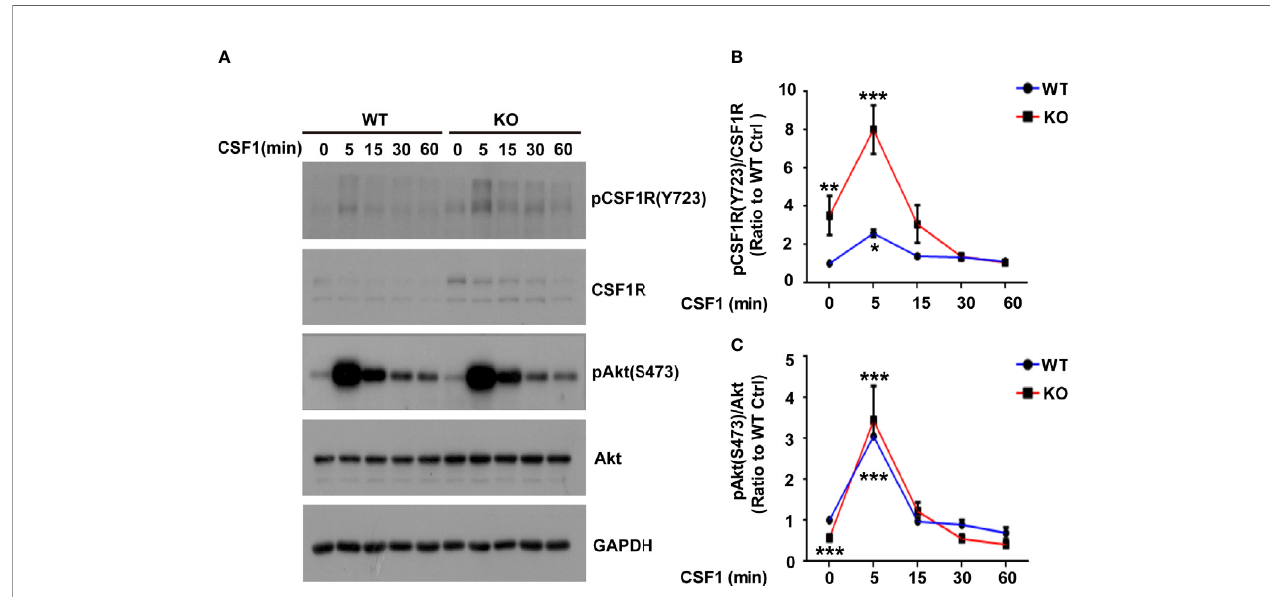
FIGURE 4 | The Akt signal is activated in response to CSF1 in WT and Trem2 KO primary microglia. (A) Primary microglia from WT or Trem2 KO mice were treated with CSF1 (50 ng/ml) for 5, 15, 30 or 60 mins and cell lysates were analyzed by Western blotting. Representative images of Western blotting for the total and phosphorylation of CSF1R and Akt are shown. (B) Protein levels of phosphorylated CSF1R at Tyr723 site (pCSF1R Tyr723 ) were quanti fi ed by densitometry and are presented as ratios to GAPDH and total CSF1R. The pCSF1R Tyr723 was increased to the highest level at 5-min CSF1 treatment and gradually returned to the normal level. (C) Protein levels of phosphorylated Akt (Ser473) were quanti fi ed by densitometry and are presented as ratios to GAPDH and total Akt. The pAkt Ser473 was increased to the highest level in response to 5-min treatment of CSF1. Two-way ANOVA with Tukey ’ s multiple comparison test. Data are plotted as mean ± SEM (n=3). Ratio to WT microglia without CSF1 treatment, * p <0.05; ** p <0.01; *** p <0.001.